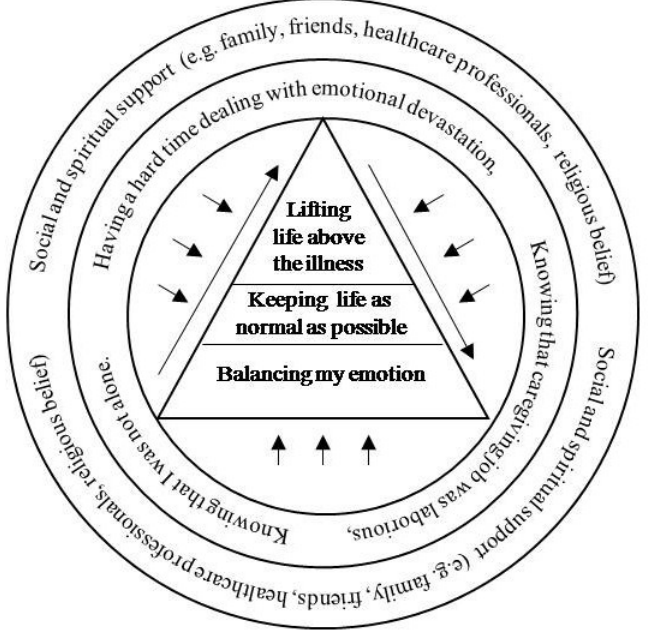
Figure 2. The relationship among the contexts and the phenomena of the experience: the experience of the caregivers who were caring for cancer